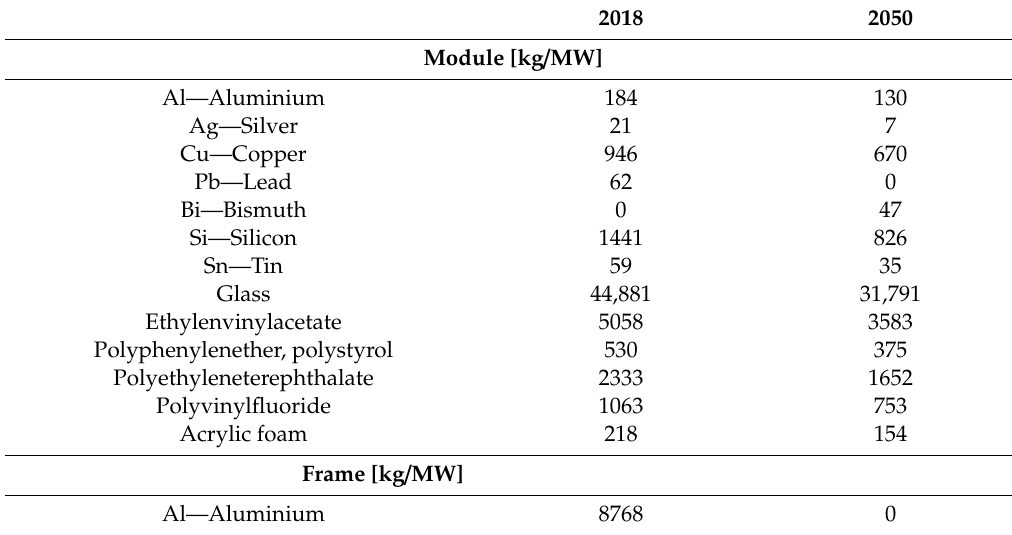
Table 2. Development of the specific material composition of PERC modules under consideration of material e ffi ciency measures and improvement of module e ffi